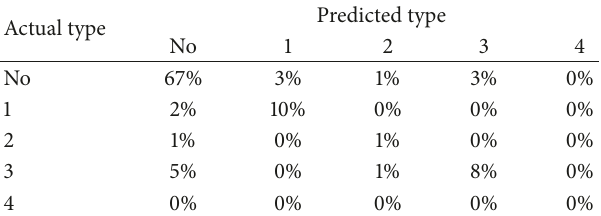
Table 10: Confusion matrix for four emergence